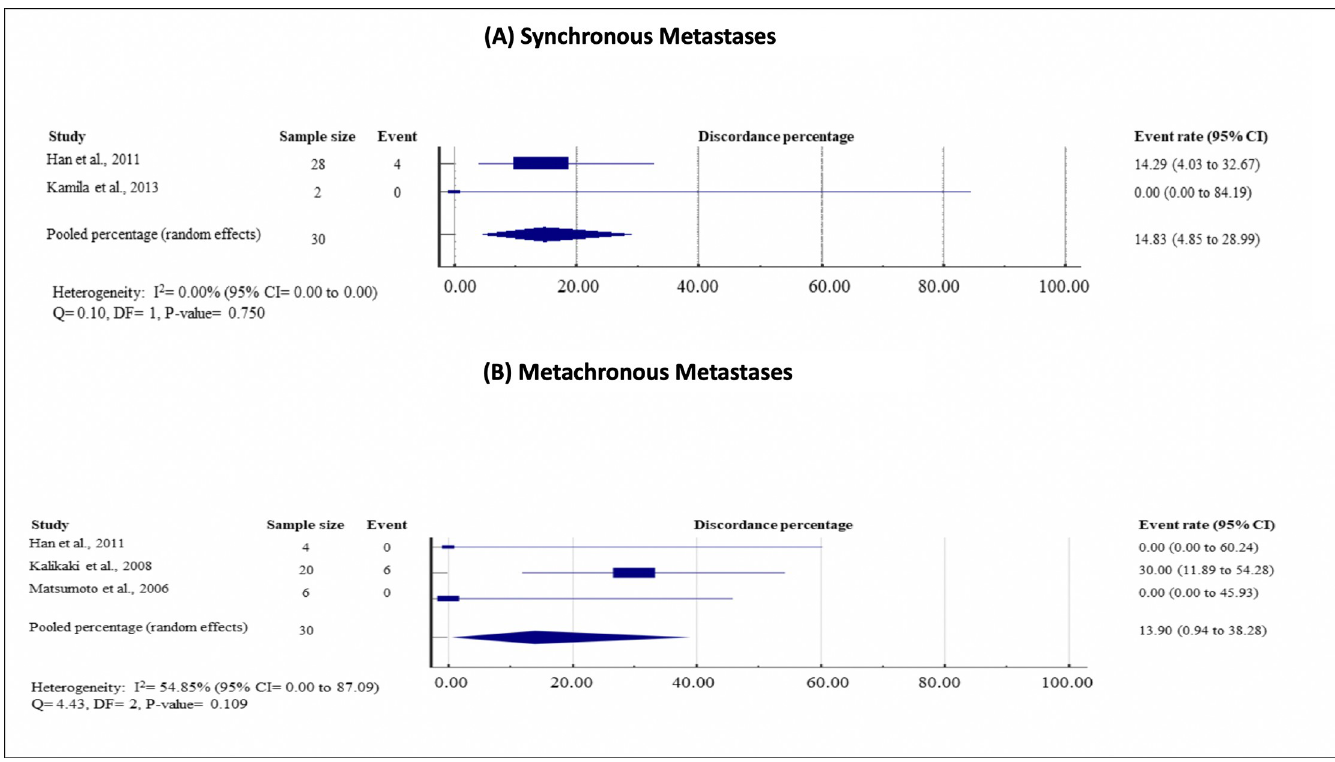
Fig 6. Study-specific and pooled estimates for EGFR mutation discordance percentages by timing of metastases. (A) Synchronous metastases; and (B) metachronous metastases. Heterogeneity was assessed using I 2 and Q test. Event was defined as discordance of EGFR mutation status between primary lung tumor and paired metastases. Abbreviation: DF = degree of freedom, CI = Confidence interval, EGFR = epidermal growth factor status.